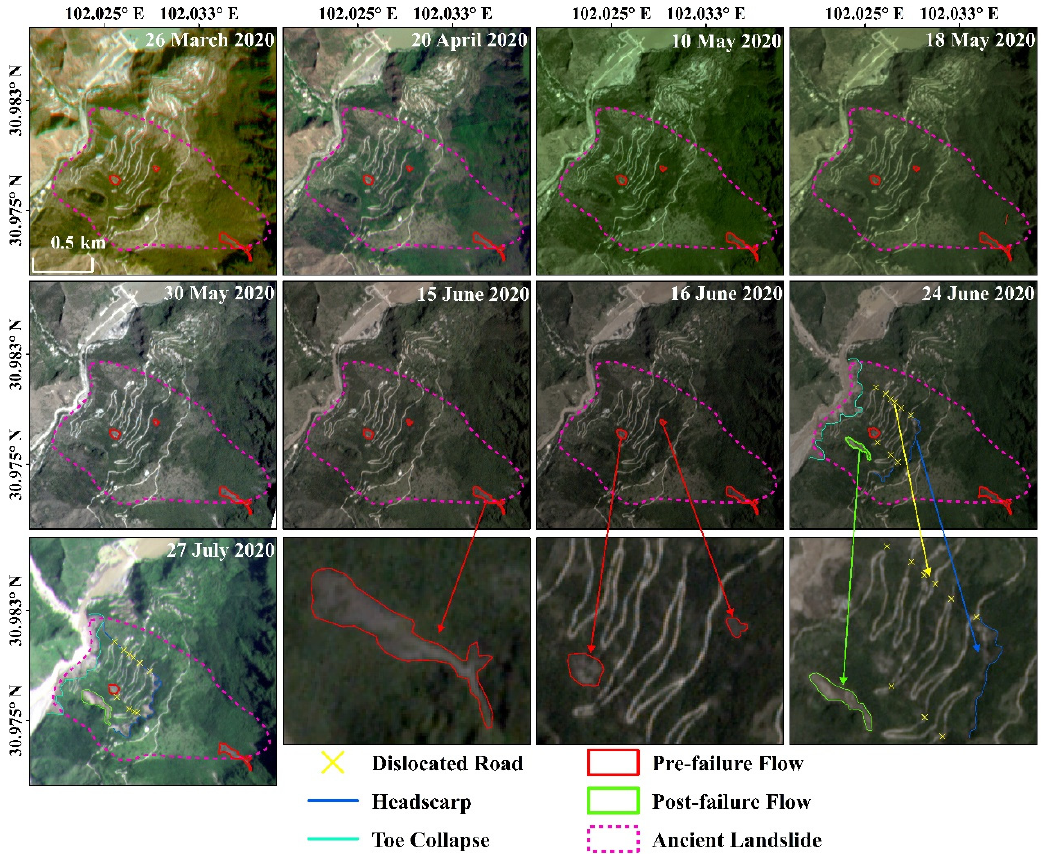
Figure 4. Time-series true color images derived from multi-temporal optical images from the Plan- etScope satellite over the ANZ Landslide, with acquisition dates annotated in the upper-right cor- ners.